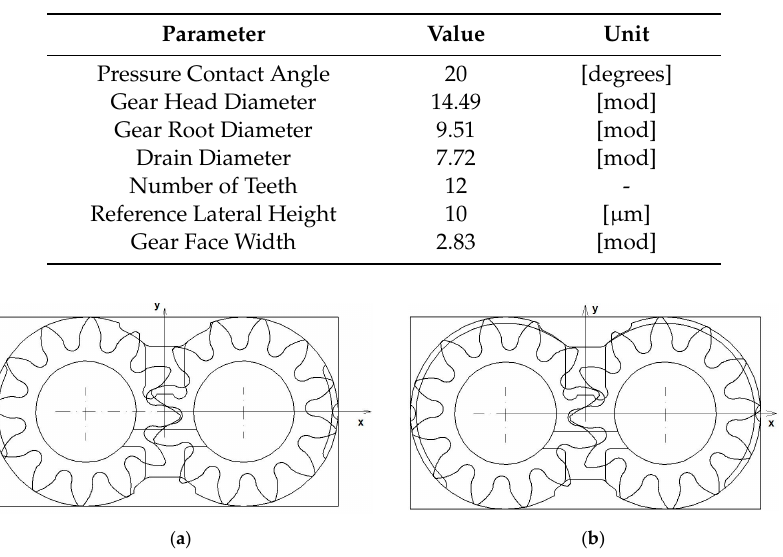
Figure 7. View of the gears and internal surface of the bushing blocks for pump 1 ( a ) and 2 ( b ).